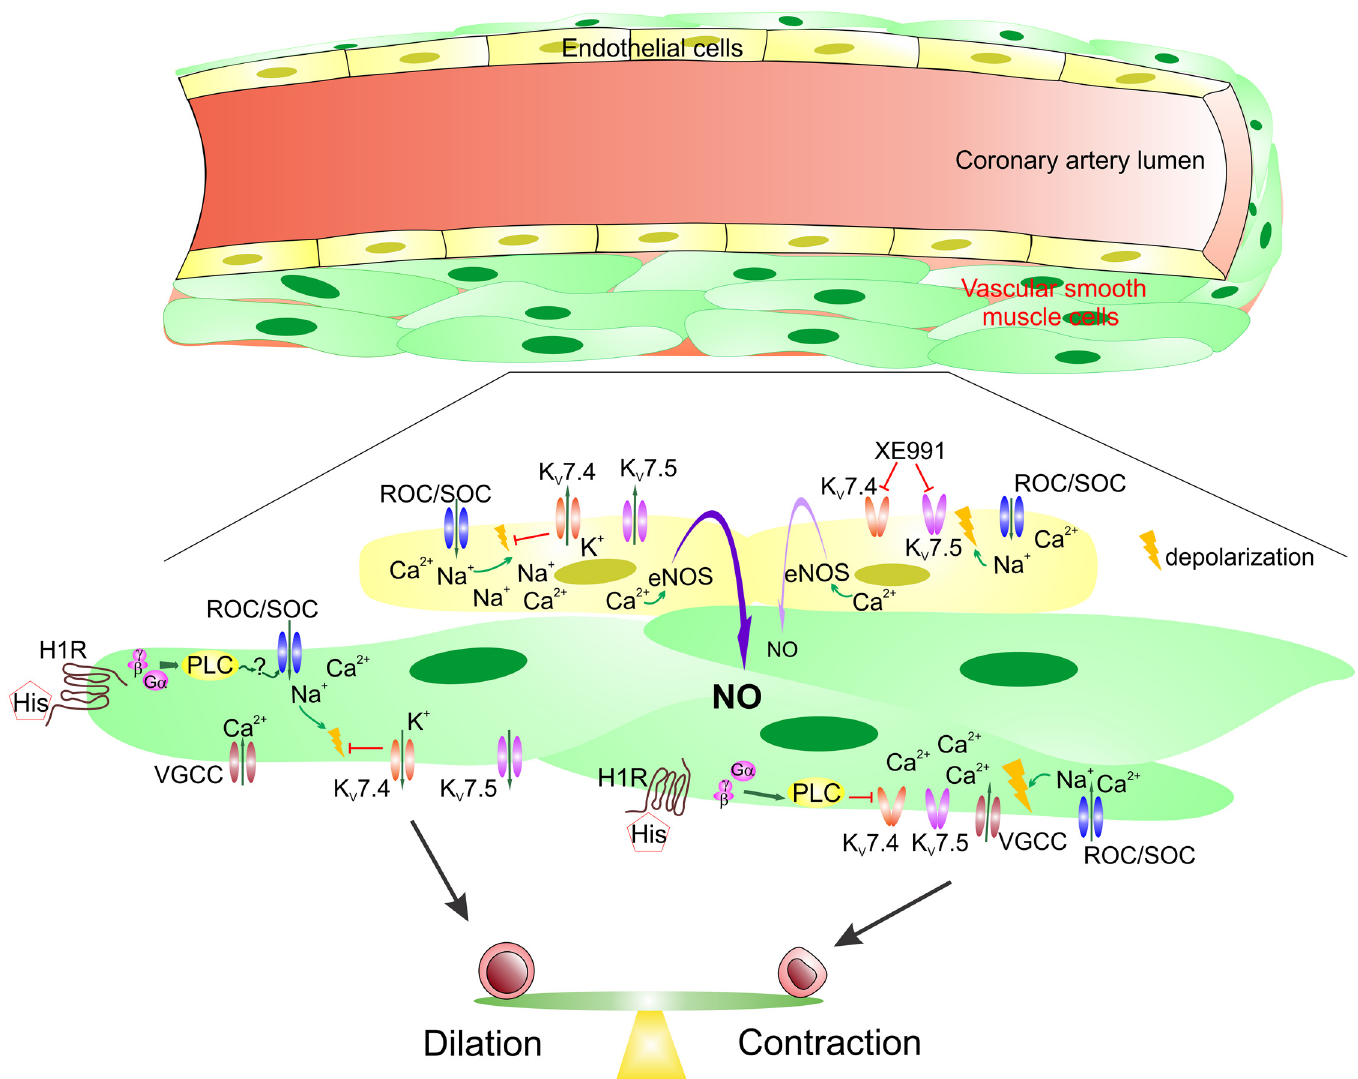
Fig 6. Diagram summarizing the roles of K v 7 channels in the pig right coronary artery. It appears that a balance between K v 7 channel activation and inhibition contributes to sculpturing the shape of histamine-induced CA contractile responses. Histamine acts on the histamine H1 receptor (H1R) expressed in CA smooth muscle cells. This results in a phospholipase C (PLC)-dependent stimulation of receptor-operated and store-operated channels (ROC/SOC) mediating cation influx that depolarizes the smooth muscle cells. In turn, smooth muscle cell depolarization activates voltage-gated Ca 2+ channels that leads to massive Ca 2+ influx into the smooth muscle cells with a consecutive smooth muscle contraction and further depolarization. Such stronger depolarization stimulates K v 7 activity repolarizing smooth muscles and weakening coronary artery ring contractions. Conversely, histamine-dependent inhibition of K v 7 channels via a PLC-dependent mechanism leads to an increased smooth muscle cell depolarization and strengthens ring contractions. In endothelium, bradykinin-dependent ROC/SOC activation also results in Na + and Ca 2+ influx that is driven by the gradient of these cations and negative potential inside endothelial cells. However, such cation influx depolarizes endothelial cells reducing the driving force. Activation of endothelial K v 7 channels likely enhances endothelium-dependent dilatory responses in the pig right coronary artery by maintaining more negative potential inside endothelial cells that results in greater Ca 2+ influx known to stimulate Ca 2+ -dependent nitric oxide synthase (eNOS) causing increased NO